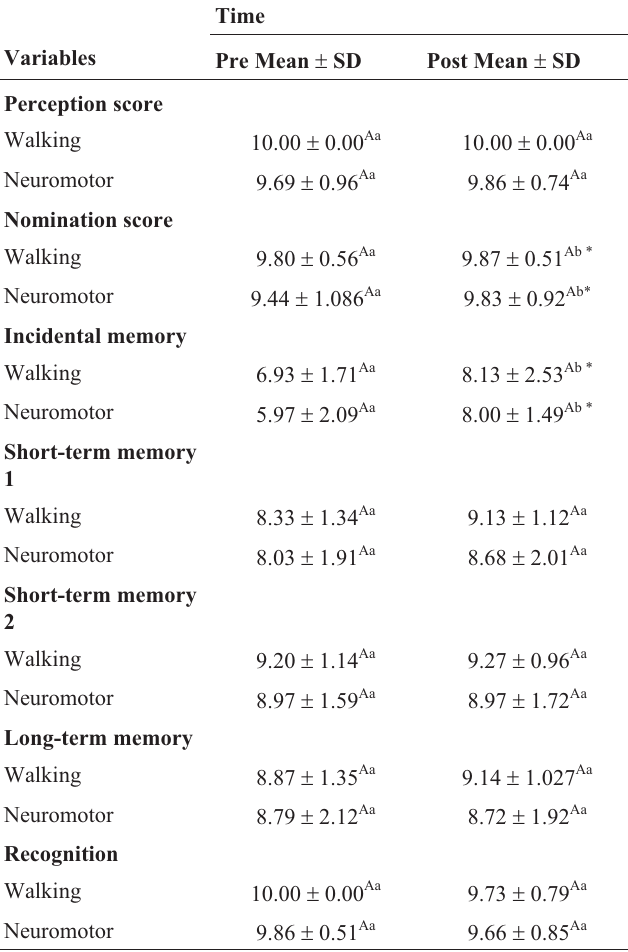
Table 3 - Mean values and standard deviation for the scores of the mem- ory test for the aerobic exercise group and neuromotor exercise group, pre-and post-intervention, Jequié-BA,